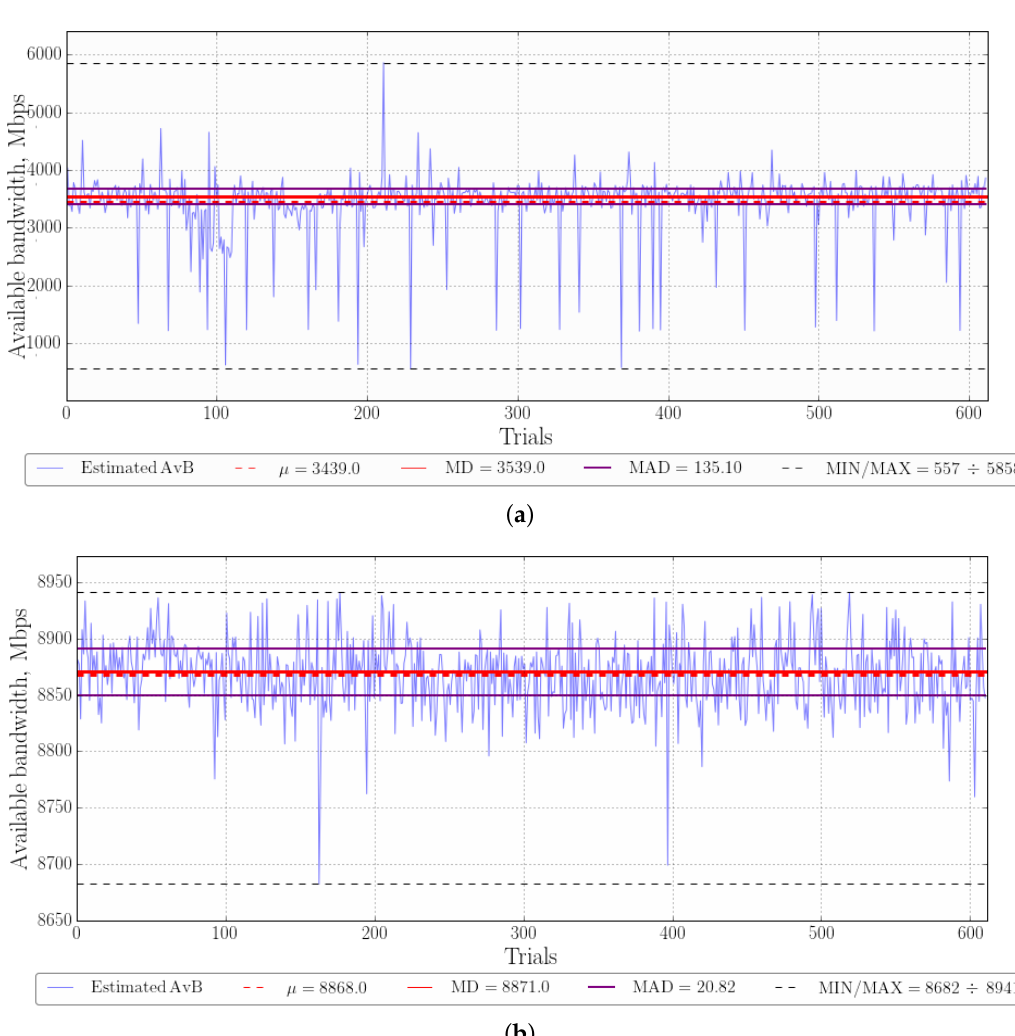
Figure 18. Kite2 AvB estimation of 10 Gbps Network on a host with 1 Gbps cross traffic: ( a ) standard system operations; and ( b ) with